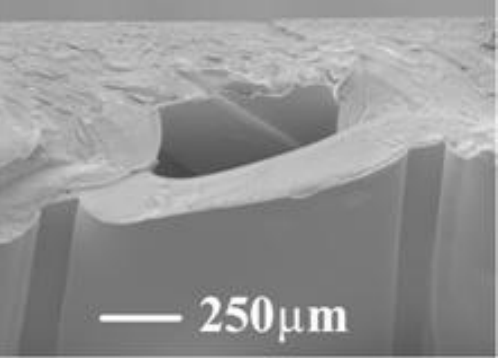
Figure 5. Scanning electron micrograph (SEM) of the break through a micro mixer